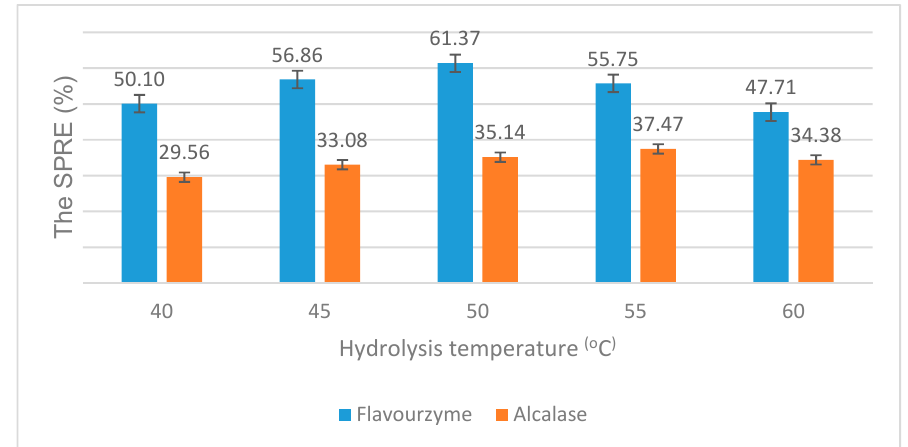
Figure 11. The effect of hydrolysis temperature on the SPRE. Figure 11. The e ff ect of hydrolysis temperature on the